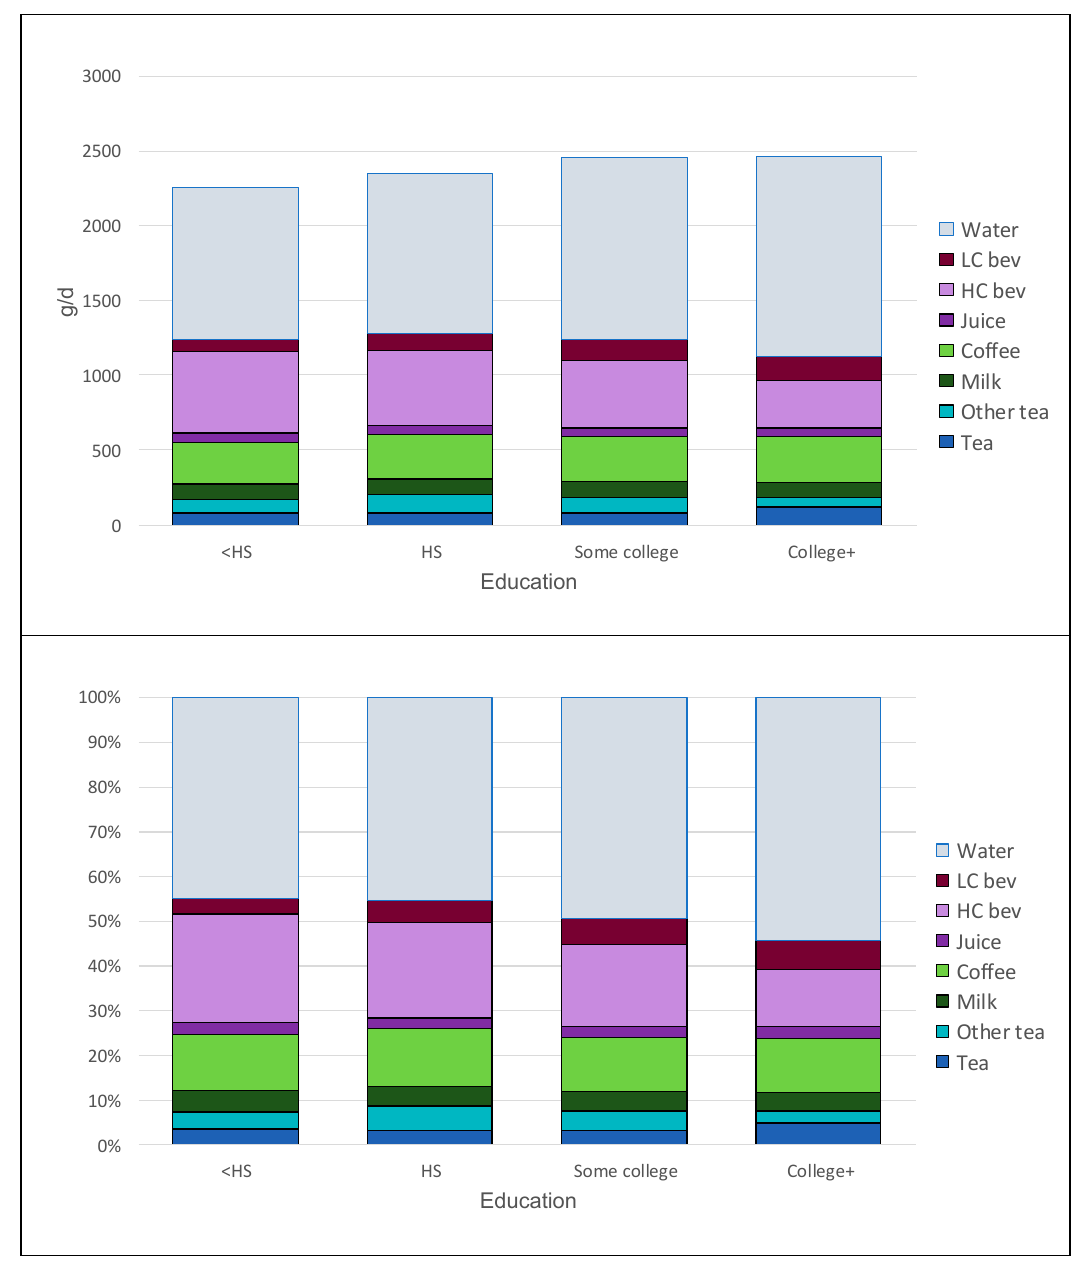
Figure3. Teaand beverageconsumptionpatternsamong adultsbyeducation. Top panelshowsamounts in g / day, while bottom panel shows percentages of total beverage consumption by beverage